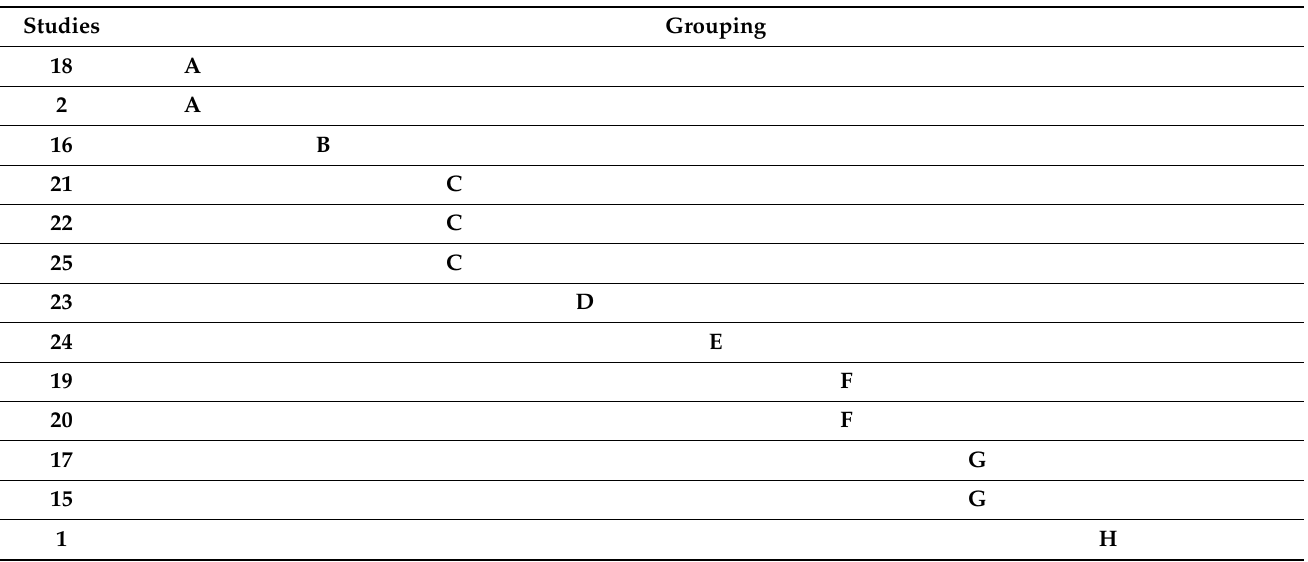
Table 7 represents the statistical analysis results of the accuracy (%) of identification and quantification by qPCR of miRNAs concerning PD. A total of thirteen studies were listed, showing each study ’ s mean and standard deviation of accuracy (%), with a total mean of 84.32 ± 7.15%. After identifying the most scientifically reliable miRNAs of the selected studies through the accuracy (%) or precision analysis, as shown in Tables 5 and 7, the main miR- NAs for AD and PD were listed in up- and downregulation, respectively, as shown in Figure 3. Additionally, there was no significant difference between studies with higher accuracy (%), according to Tukey’s analysis, with p > 0.05 in the 95% CI. The study groups presented these results with the same letter, as shown in Table 8. Table 8. Tukey's statistical analysis among studies with the highest accuracy (%), with p > 0.05 at 95% CI. The study groups presented these results with the same letter. Studies